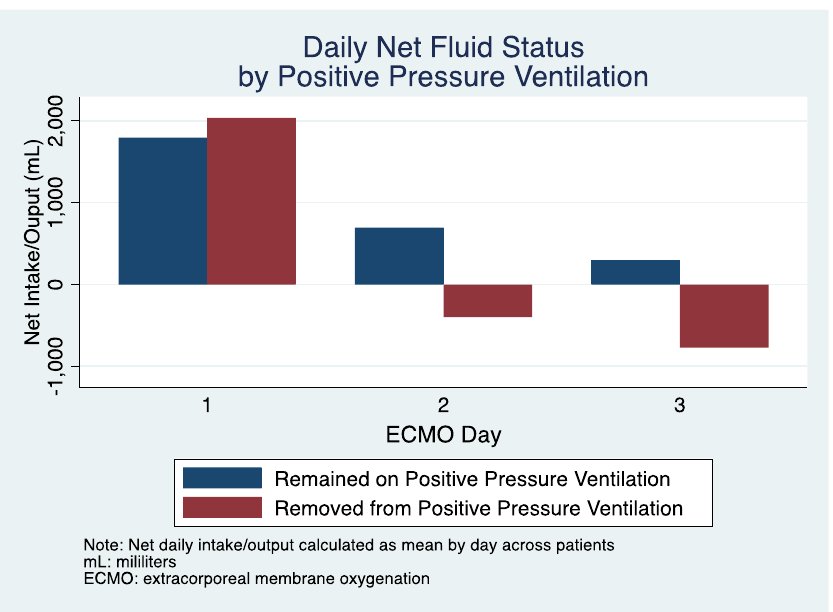
Figure 1. Daily net fluid status over the first three days after ECMO cannulation in patients who remained on positive pressure ventilation (PPV) (blue) and those removed from PPV (red). The average duration from cannulation to mobilization (i.e., out-of-bed) was 18 days with PPV and 7.1 days without PPV ( p = 0.015, Figure 2). There was no statistical difference between groups based on the Riker Sedation Agitation Score (PPV 2.8 vs. non-PPV 3.6; p = 0.084) or in the mean duration until GCS of ≥11T (8.1 days with PPV vs. 9.7 days without PPV; p = 0.553). The mean duration of hospital LOS (among survivors) was 41 days in patients receiving PPV and 31 in those removed from PPV ( p = 0.222), with a majority of patients (38%) discharged to home, regardless of PPV status.